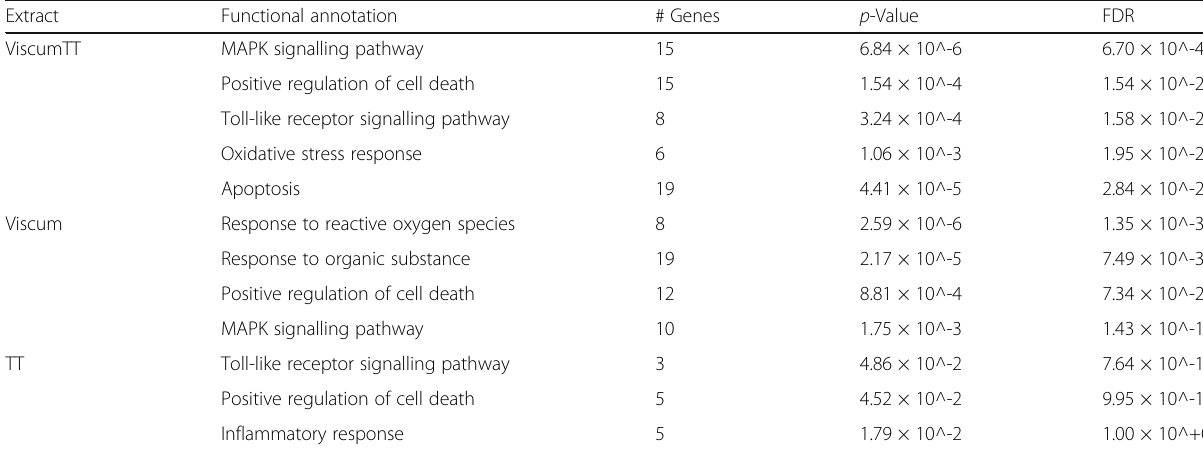
Table 1 Significantly regulated KEGG pathways in TC-71 cells treated 24 h with viscumTT, viscum or TT versus untreated control cells